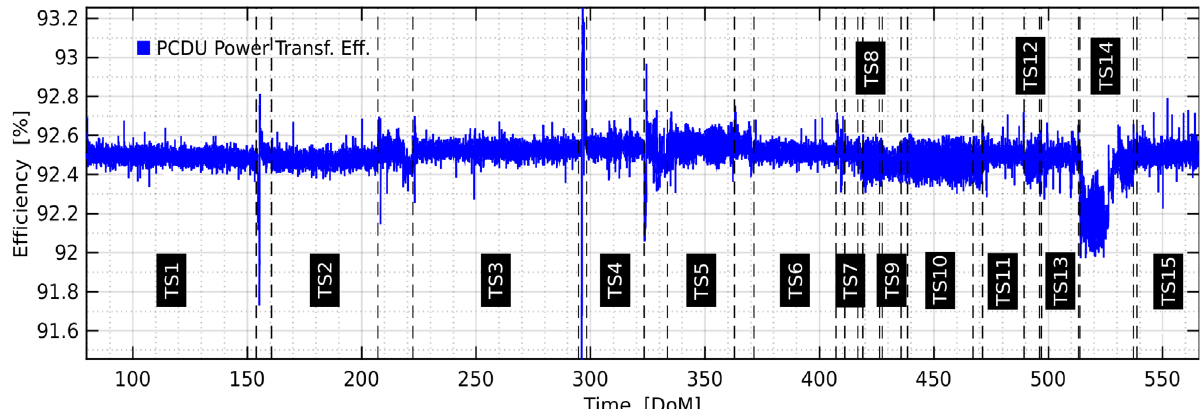
Figure 6. PCDU power transfer effciency, g [ t